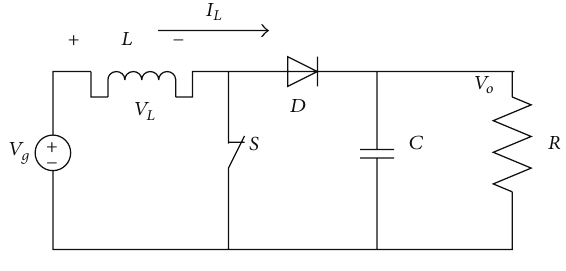
Figure 16: Circuit diagram of boost converter.